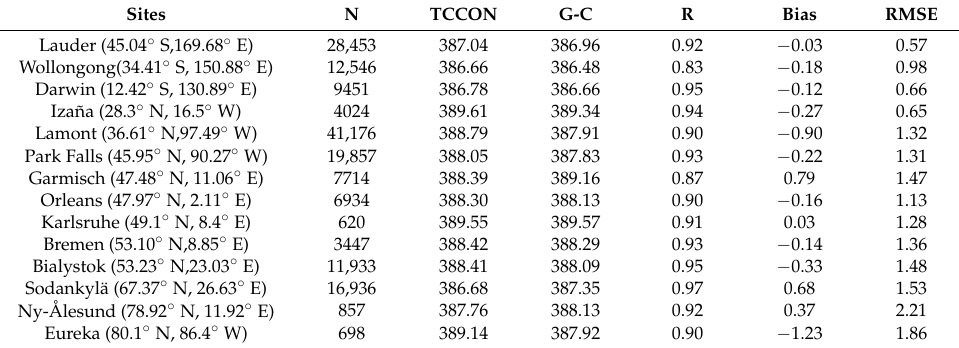
Table 3. Statistics of number of XCO 2 data (N) at TCCON sites, averaged XCO 2 , correlation coefficient (R), averaged bias (Bias) and root-mean-square error (RMSE) between GEOS-Chem (G-C) and TCCON during 2009–2011.